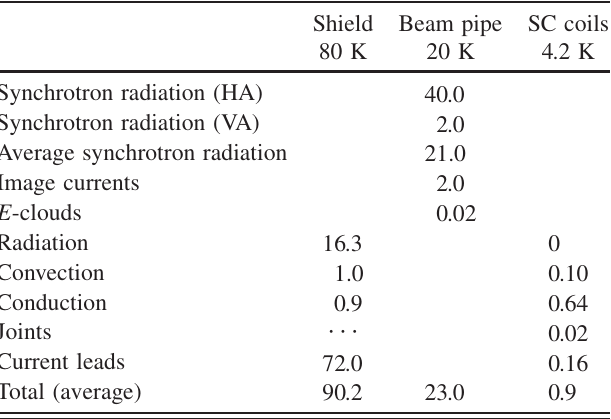
TABLE X. Summary of the average heat loads (all sources) at the different temperature levels in